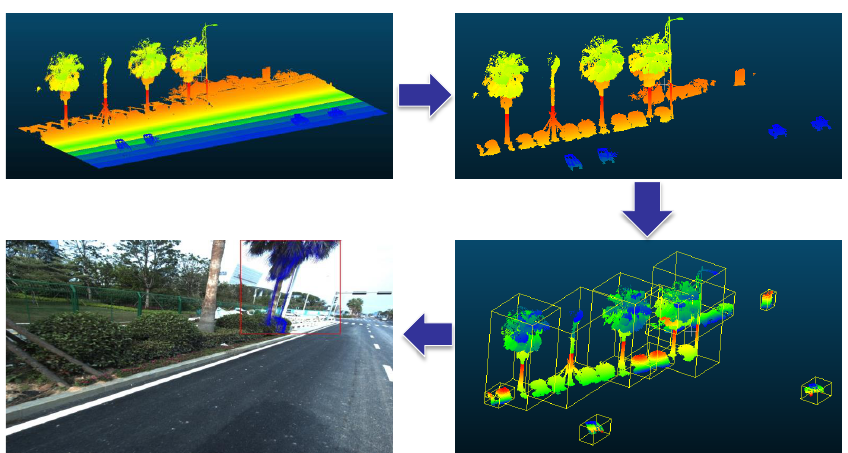
Figure 6. The procedure of obtaining individual MLS objects.